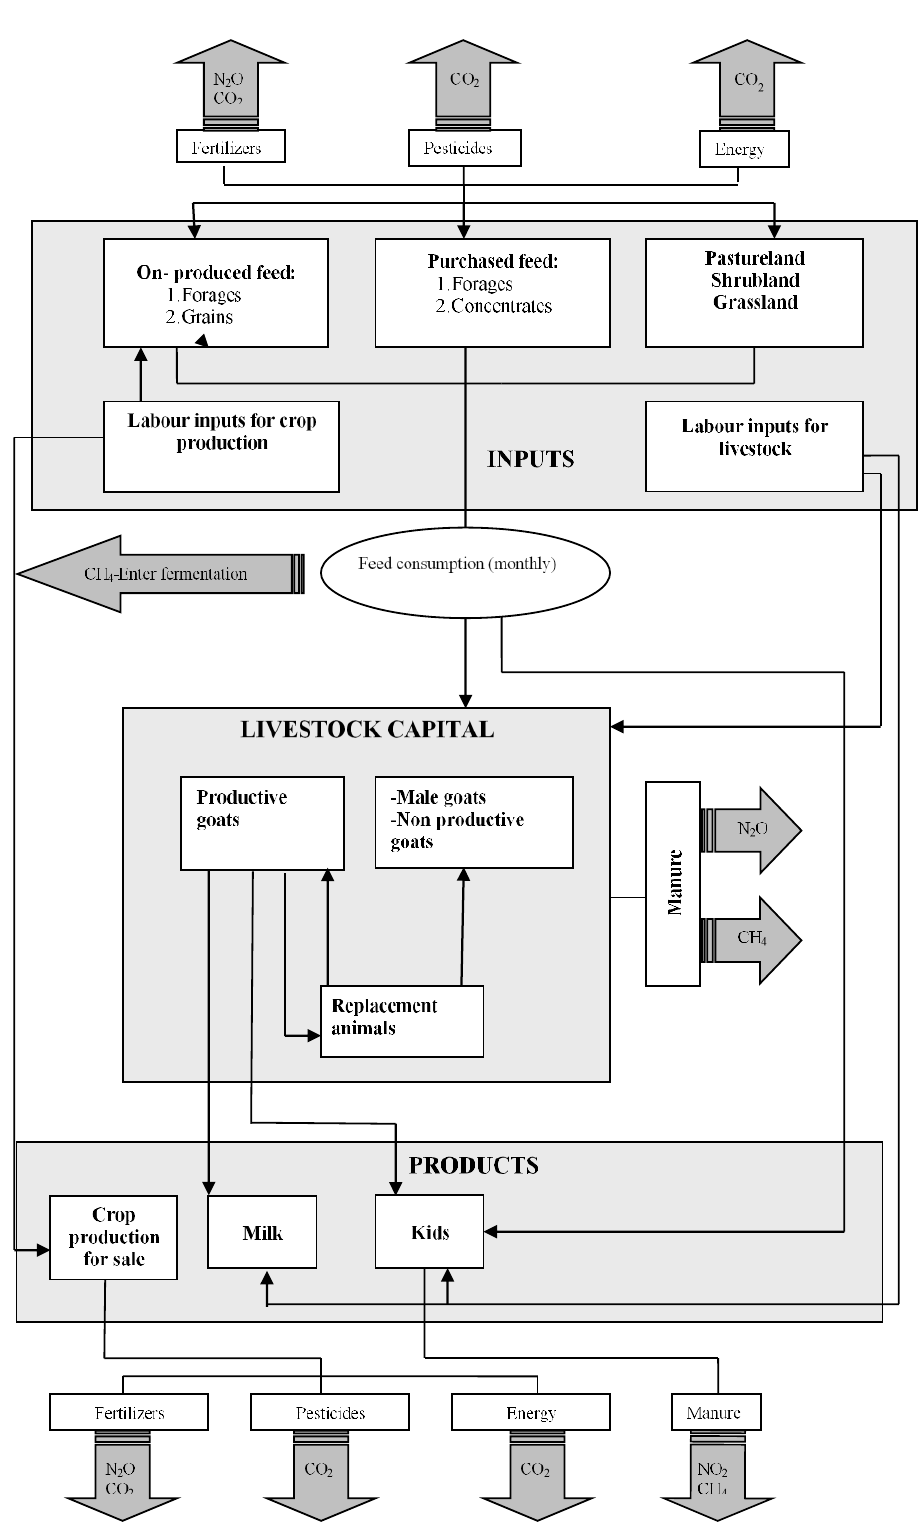
Figure 2. Graphical representation of the mathematical programming model and the emission sources considered in the analysis.